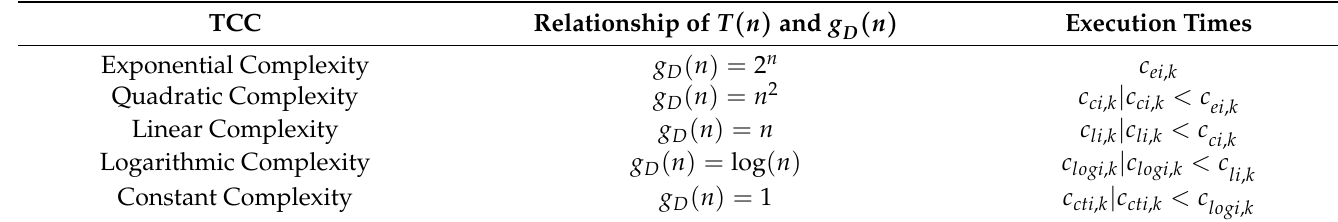
Table 2. Classification of the temporary computational complexity of an algorithm based on the behavior analysis of T ( n )